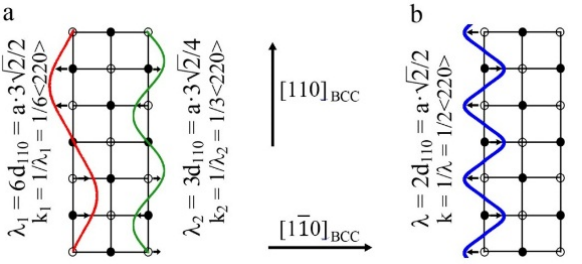
Figure 15. Shuffle schemes promoting D0 3 cubic lattice transformations via ( a ) ISS-I and ( b ) ISS-II [62].